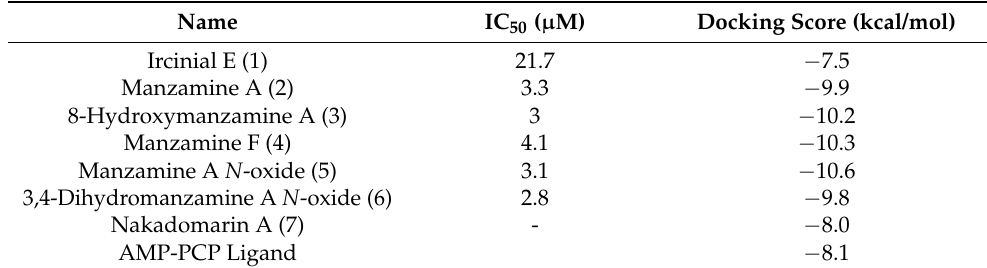
Table 1. The docking scores and biological activity of a series of manzamine alkaloids with natural kinase substrate